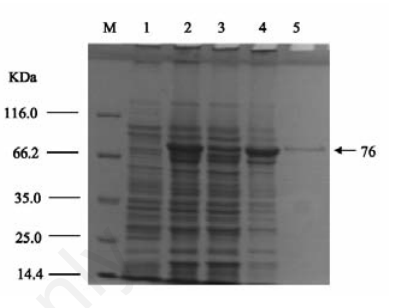
Figure 4. Purification of EhV 99B1 Major Capsid Protein (MCP) after recombinant expression in E. coli . Shown is an SDS- PAGE analysis of GST-MCP fusion pro- teins by Coomassie blue-stained polyacry- lamide gel. After induction with IPTG, the cells were lysed and the soluble GST-MCP fusion fraction was purified by using a Phenyl-Sepharose CL- 4B hydrophobic column. Lane M, Mr markers, sizes of which are indicated to the left. lanes 1-2, whole cell lysates uninduced and induced for GST-MCP expression; lines 3-4, cell extract supernatant and cell extract sedi- ment fraction. lane 5, the purified fusion protein migrated on SDS-PAGE with an apparent molecular mass of 76 kDa.